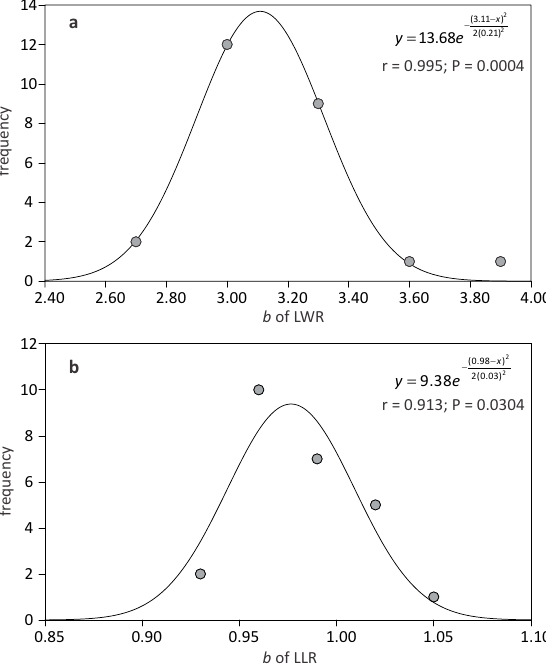
Figure 3. Distribution of b values of (a) LWR and (b) LLR for all the species and from all the Rivers considered in the current study. Both the plots show good fit for the normal